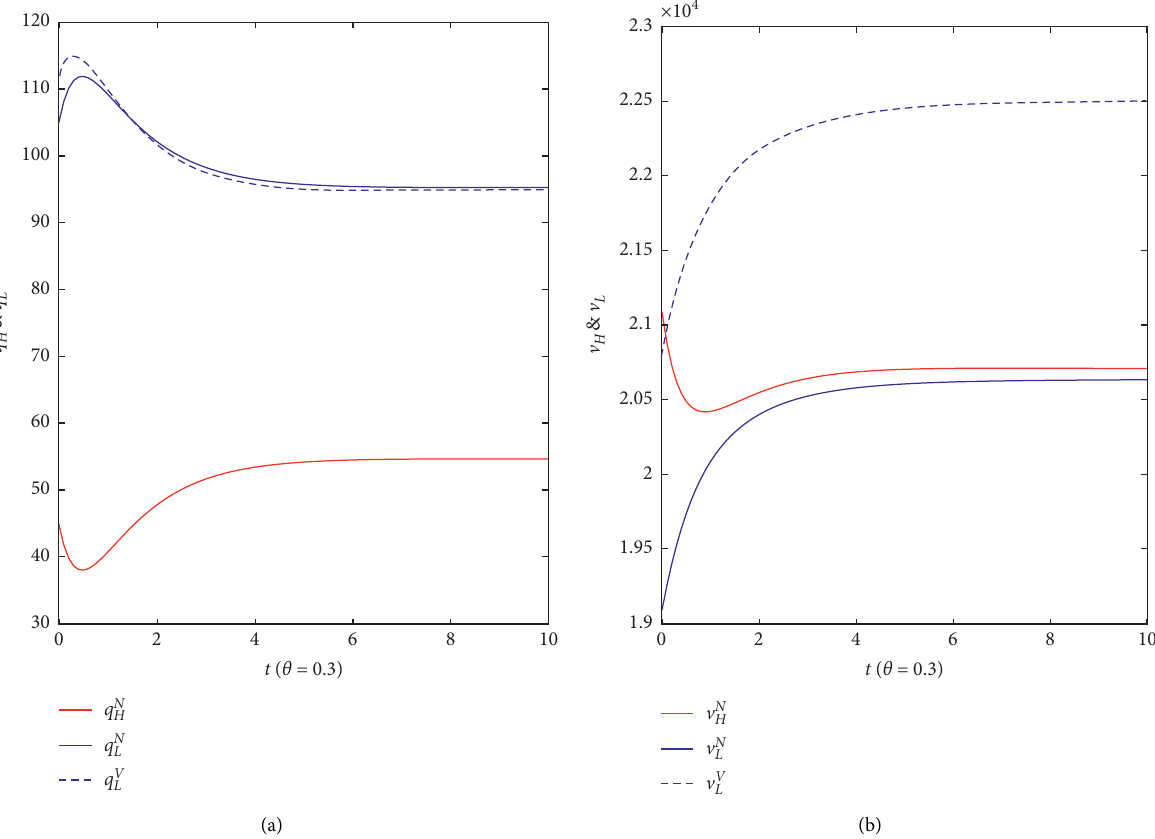
Figure 3: (a) Comparison of dynamic sales of the free-riding manufacturer and the green manufacturer under different modes ( θ � 0.3). (b) Comparison of dynamic profits of the free-riding manufacturer and the green manufacturer under different modes ( θ �